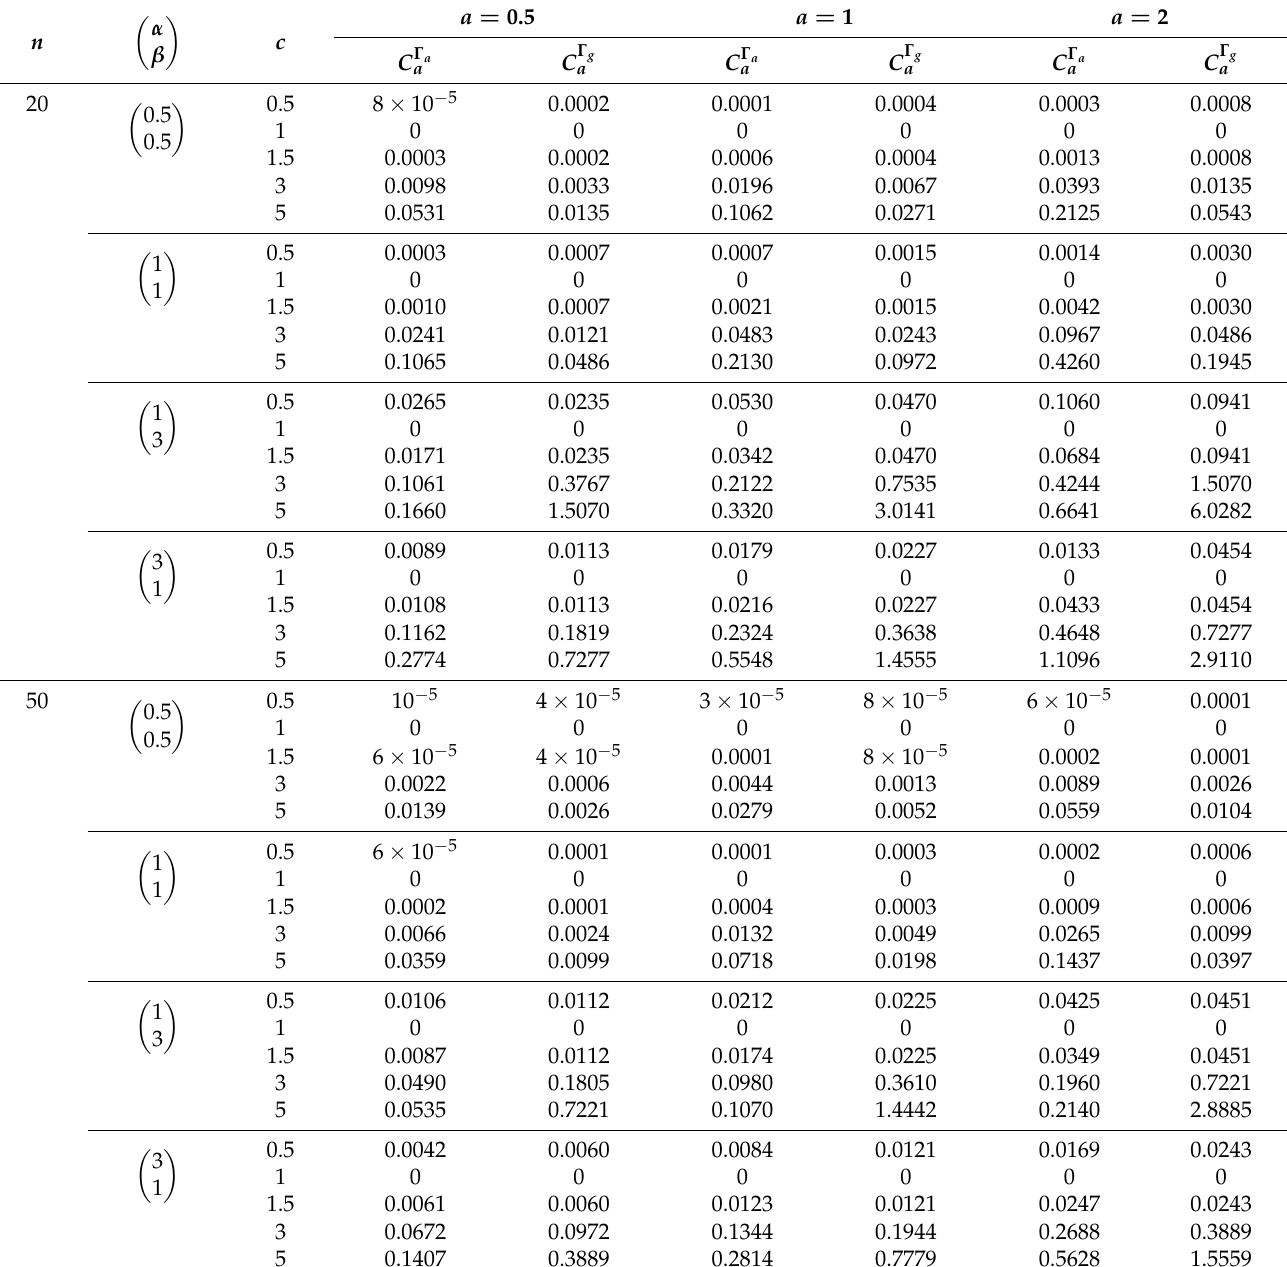
Table 1. Values of the local curvature for two classes Γ a and Γ g for a sample generated from